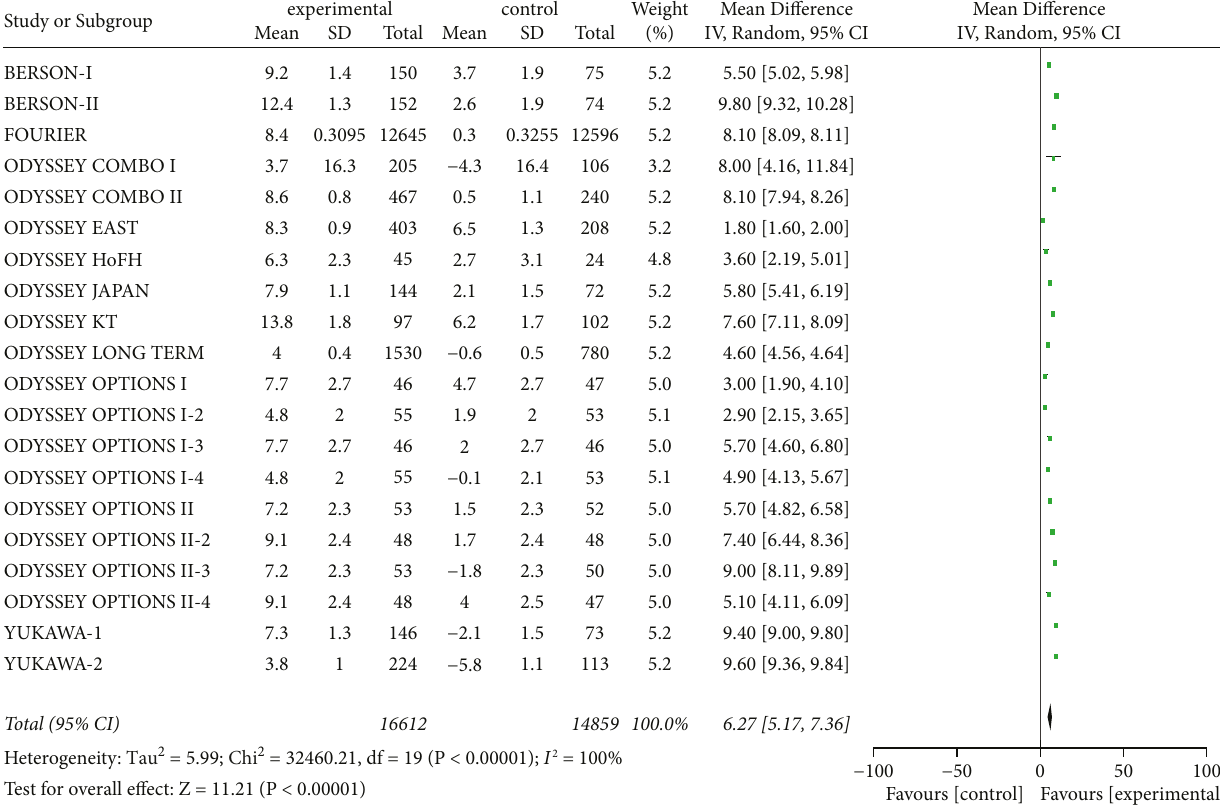
Figure 10: Comparison of the rise of serum HDL-C (%) from baseline between control group and experimental group.